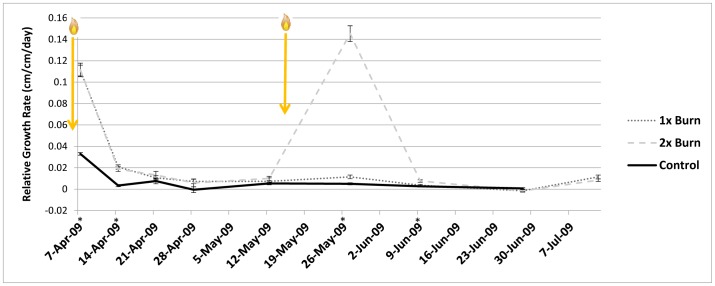
Mean relative growth rate of tillers (cm/cm/day) (±1 S.E.) across the duration of the experiment, as measured at each of nine measurement intervals (measurements for all treatments were made within a two-day window for each interval).Asterisks indicate dates for which there was a significant difference between treatment means. Flame symbols indicate when the two prescribed burn treatments were applied to either both the 1x and 2x treatments for the first burn (25 March), or the 2x treatment only for the second burn (12 May).